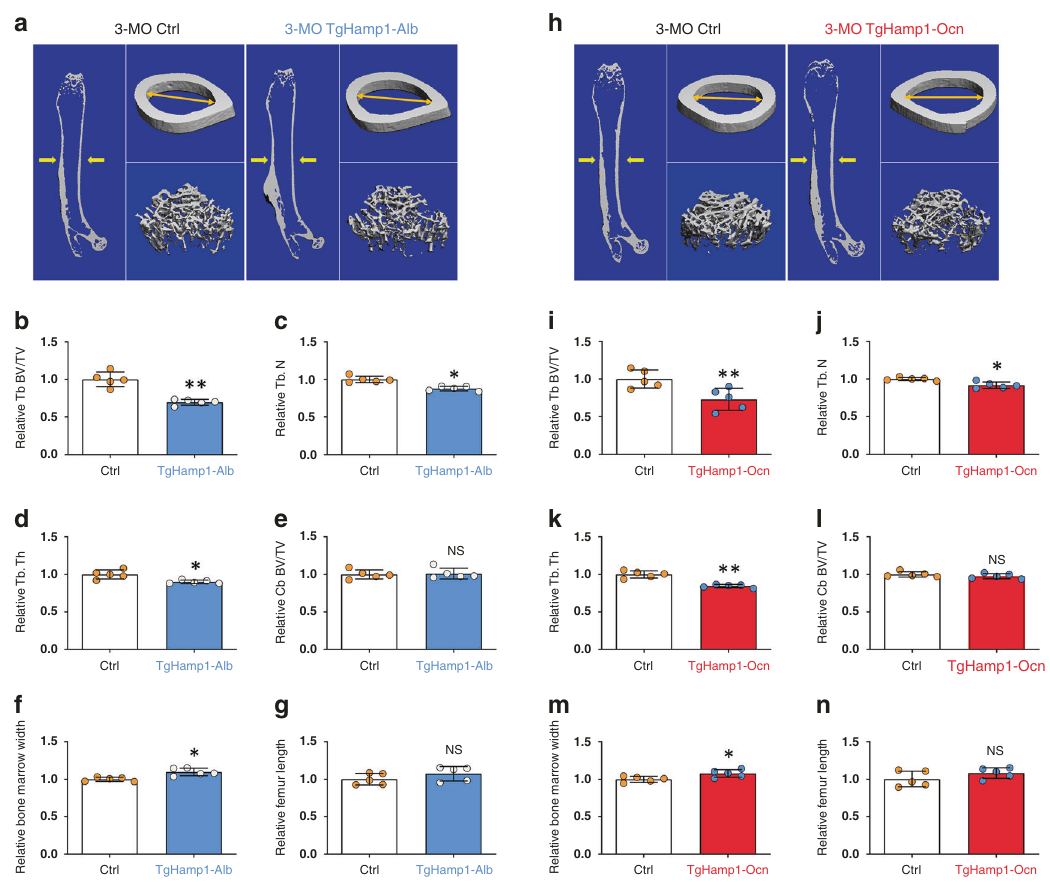
Fig. 2 Decreased trabecular bone mass in 3-month-old TgHamp1-Alb and TgHamp1-Ocn mice. a μ CT analysis of femurs from 3-MO Ctrl and TgHamp1-Alb littermates. Five different male mice of each genotype were examined blindly. Representative 3D images are shown in ( a ). b – g Quantitative analyses of the trabecular bone (Tb) volume over total volume (BV/TV), Tb number (Tb. N), Tb thickness (Tb. Th), cortical bone (Cb) volume/TV, bone marrow width and femur length by direct μ CT. The data are in ( b – g ) are presented as the mean ± SD. * P < 0.05; ** P < 0.01; NS, no signi fi cant difference. h μ CT analysis of femurs from 3-month-old Ctrl and TgHamp1-Ocn littermates. Five different male mice of each genotype were examined blindly. Representative 3D images are shown in ( h ). i – n Quantitative analyses of Tb BV/TV, Tb. N, Tb. Th, Cb BV/TV, bone marrow width and femur length by direct μ CT. The data in ( i – n ) are presented as the mean ± SD. * P < 0.05; ** P < 0.01; NS no signi fi cant regions were analyzed in nondecalci fi ed femur sections from the injected mice. To our surprise, no signi fi cant difference was observed in Ec.MAR, Tb.MAR, Ec.MS/BS, Tb.MS/BS, Ec.BFR or Tb.BFR between TgHamp1-Alb and control mice (Supplementary Fig. S6a – d), suggesting normal bone formation. This fi nding was further con fi rmed by analysis of serum levels of osteocalcin (Supplementary Fig. S6e), a bone formation marker, and in vitro osteoblastogenesis by ELISA (Supplementary Fig. S7a – c). The mRNA levels of osteoblastogenesis-related genes, including runt- related transcription factor 2 (Runx2), transcription factor Sp7 (Sp7), alpha-1 type I collagen (Col1 α 1) and osteopontin (Opn), were not different between OB progenitors derived from TgHamp1-Alb mice compared to those derived from control mice (Supplementary Fig. S7d). In addition, there were no signi fi cant differences in proliferation and apoptosis between BMSCs derived from TgHamp1-Alb mice and those derived from control mice (Supplementary Fig. S8a, b). The Runx2 + cell number in trabecular bone and cortical bone regions was also not different between 3-month-old TgHamp1-Alb mice and control mice (Supplementary Fig. S9a, b). These results suggest that hepatocyte-derived hepcidin has little or no effect on OB-mediated bone formation. Unlike in TgHamp1-Alb mice, the MAR, MS/BS, and BFR of trabecular bone but not Ec. cortical bone were decreased (Supplementary Fig. S6f – i), indicating a decrease in trabecular